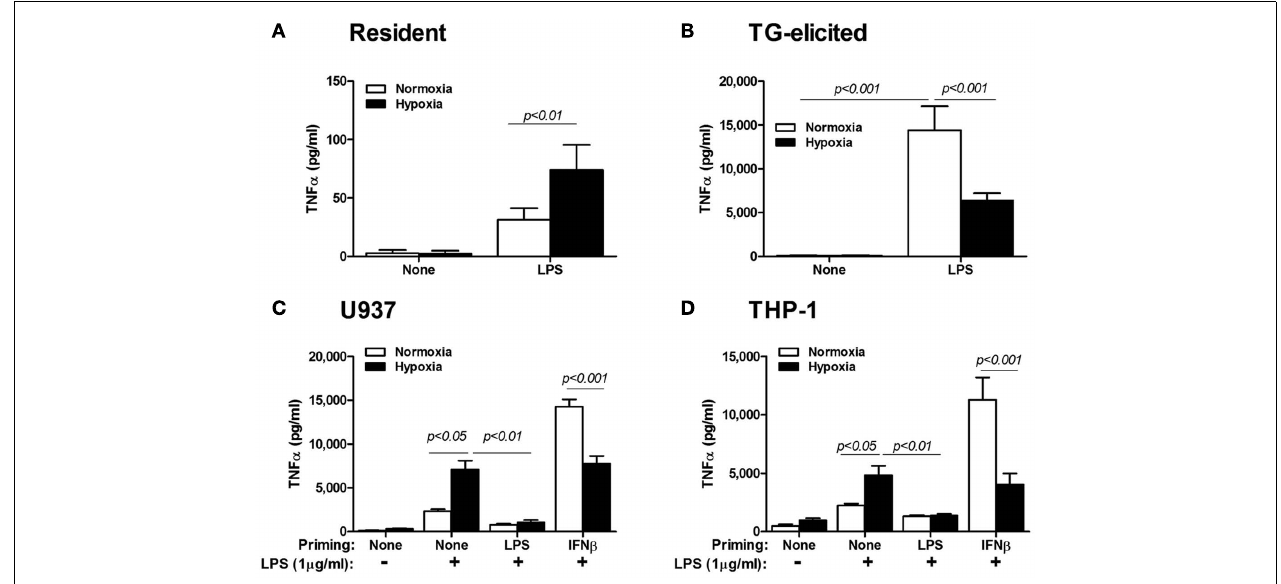
FIGURE 1 | Priming of M φ affects the hypoxic response. (A) Resident peritoneal M φ ( n = 14) or (B) TG-elicited peritoneal M φ ( n = 16) were subjected to hypoxia ( < 0.3% O 2 ) for 24h, with or without stimulation with LPS (1 μ g/ml). Hypoxia inhibited the secretion of high amounts ofTNF α that were produced in normoxia in primedTG-elicited M φ , while an opposite response to hypoxia was observed for the naïve resident M φ .The